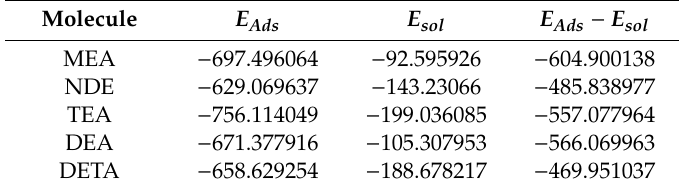
Table 2. Adsorption and solvation energy of five molecules. (kcal /